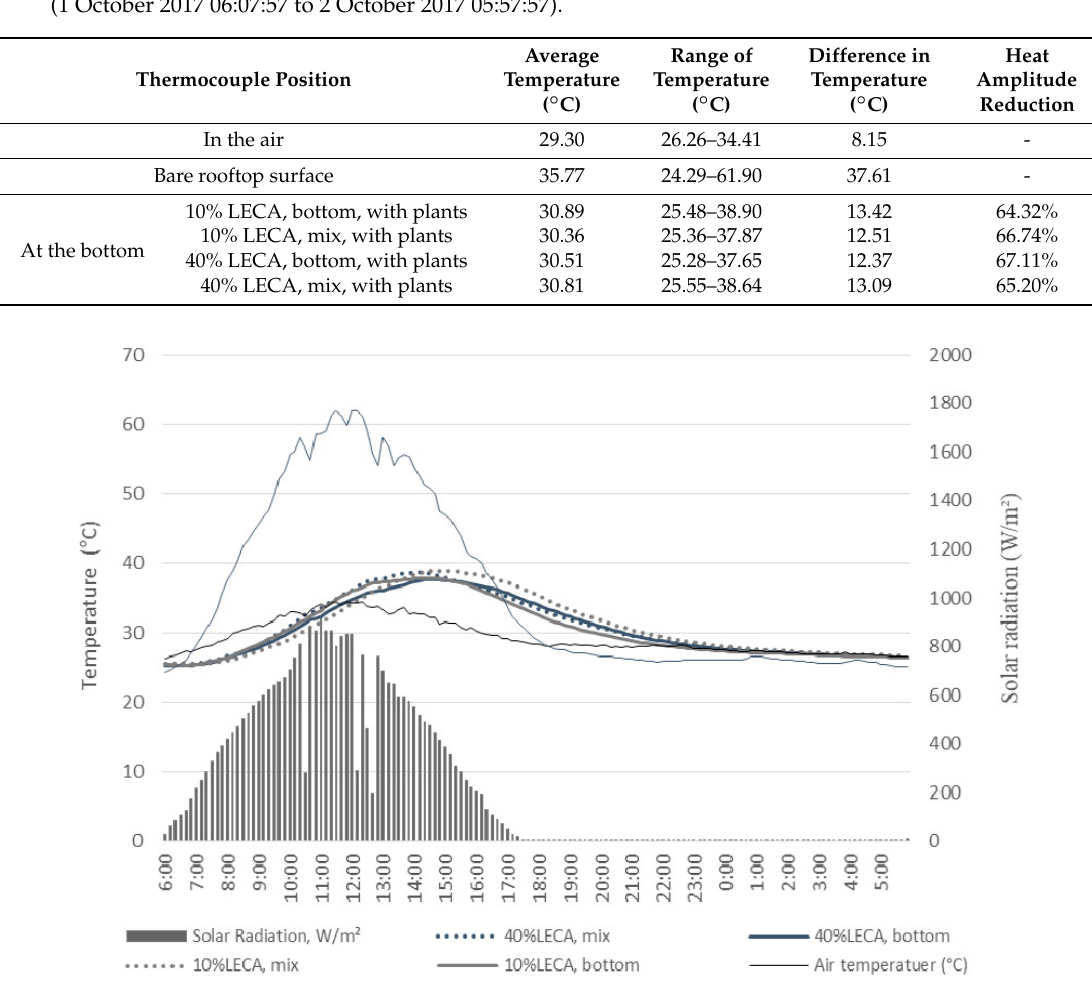
Table 13. Reduction in heat amplitude in the cases of the roofs with 10% and 40% LECA laid at the bottom with Ipomoea batata , and of 10% and 40% LECA mixed with the soil with Ipomoea batatas